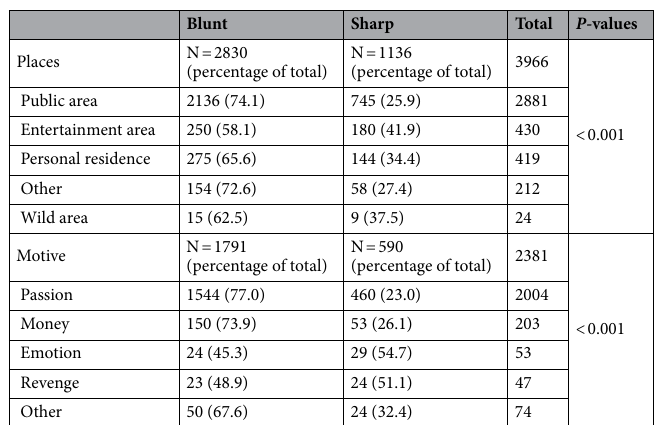
Table 2. Places of and motive for injury stratified by the type of instrument used to inflict injury.